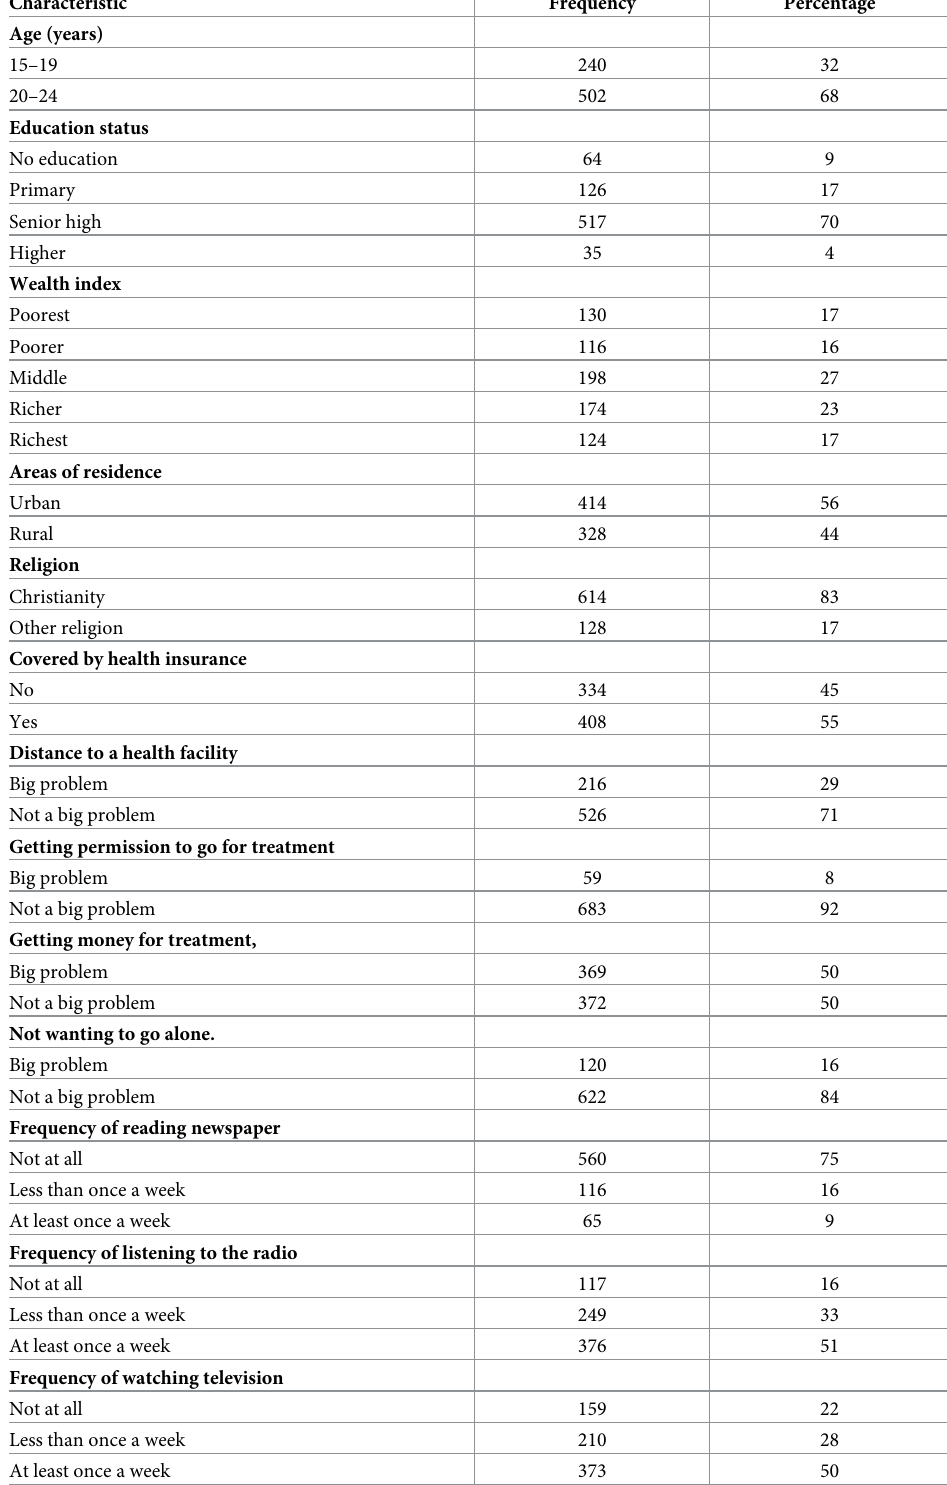
Table 1. Participant characteristics (n =